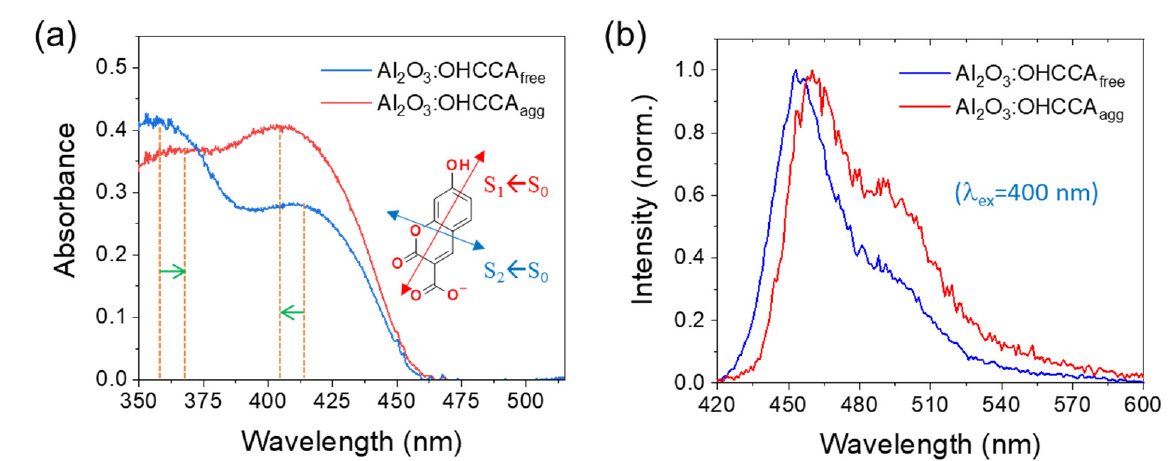
Figure 1. Steady-state measurements: ( a ) Steady-state absorption and ( b ) Steady-state fluorescence spectra of the film samples. The dashed vertical lines in ( a ) indicate the center wavelengths for the two lowest electronic transitions. The inset of ( a ) shows the transition dipole alignments for the S 1 –S 0 and S 2 –S 0 transitions. For the fluorescence measurements, the excitation wavelength was 400 nm.